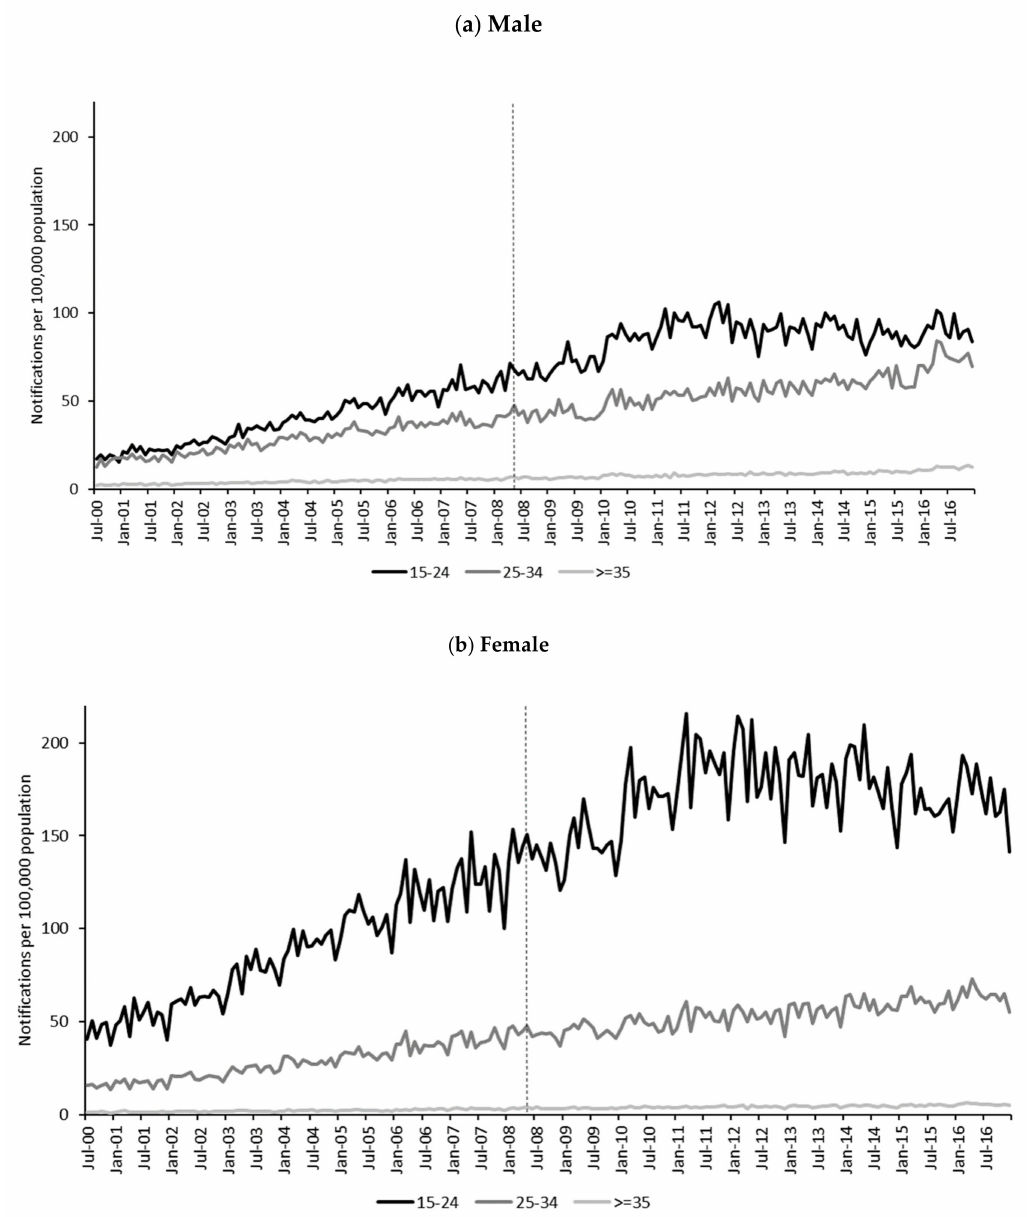
Figure 2. Monthly chlamydia notification rates per 100,000 population (primary outcome) by gender and age group, July 2000 to December 2016. Alcopops tax intervention point indicated by vertical dotted line at May